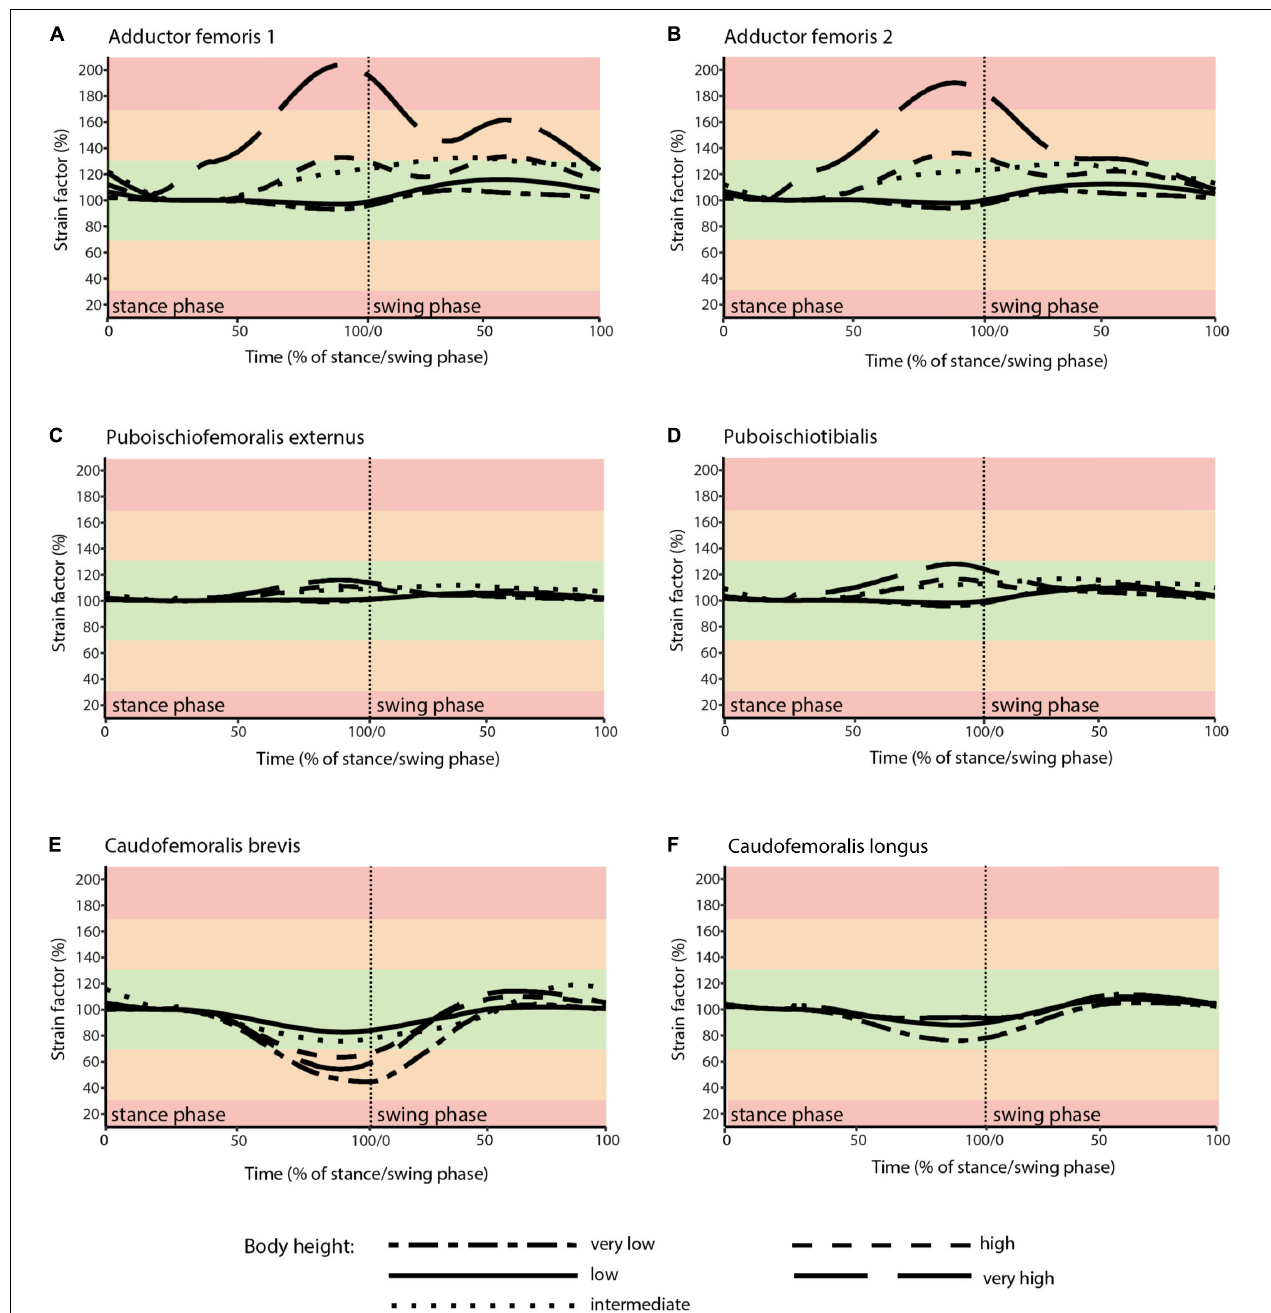
FIGURE 6 | Muscle strains plotted against percentage of stance and swing phase in Caiman for each of the five analyzed body heights. (A) ADD1; (B) ADD2; (C) PIFE; (D) PIT; (E) CFB; (F) CFL. Red areas of the plots involve muscle tension beyond 170% or compression below 30% of reference length and were considered implausible in this study. Green areas of the plots represented optimal muscle length for the generation of force (between 70 and 130% of reference length). Orange areas represent feasible muscle strains with limited potential for force